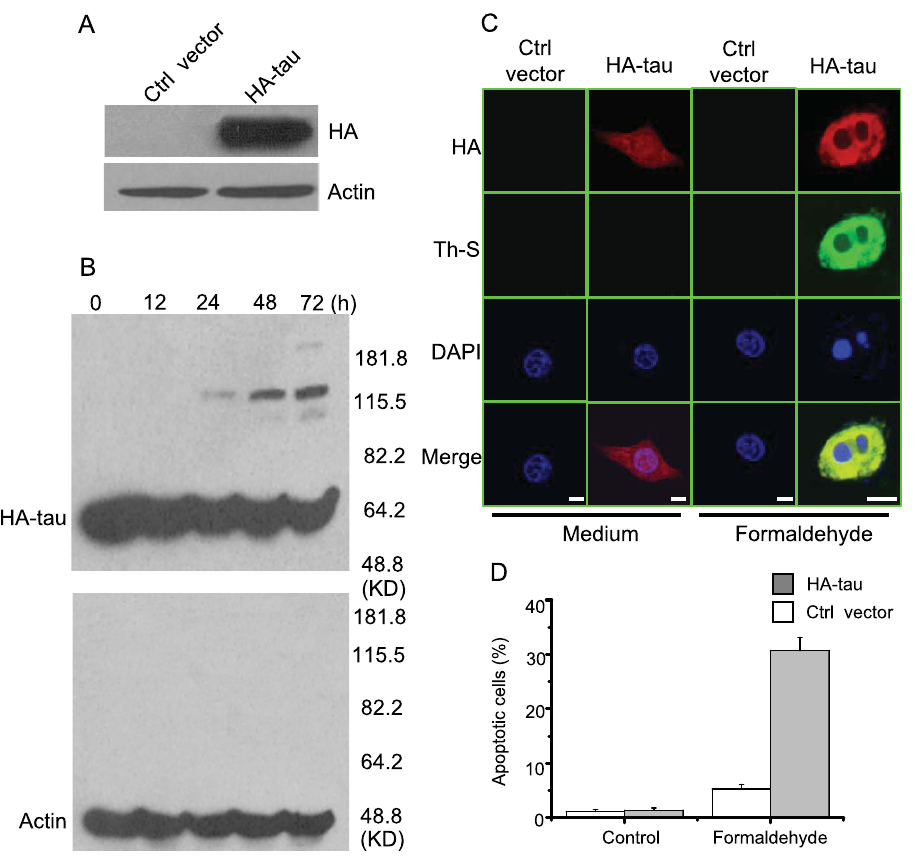
Figure 10. Toxicity of tau aggregation to HEK 293 cells in the presence of formaldehyde. HEK 293 cells were cultured and transient with HA-tau or the control vector, followed by incubation with 0.0002% formaldehyde for 72 h. Immunolabelling with the monoclonal antibody HA was used to visualize tau expression ( A ) and tau aggregation in the presence of 0.0002% formaldehyde for different times ( B ). b -actin was used as a protein loading control. Immunostaining detected tau aggregation in 293 cells after treated with formaldehyde for 72 h ( C, Bar: 25 m m). Other conditions were similar to SY5Y cells shown in Figure 9. Quantitative analysis is presented in D . Apoptotic cells are characterized by nuclear condensation and diffraction. At least 200 apoptotic cells were counted in each